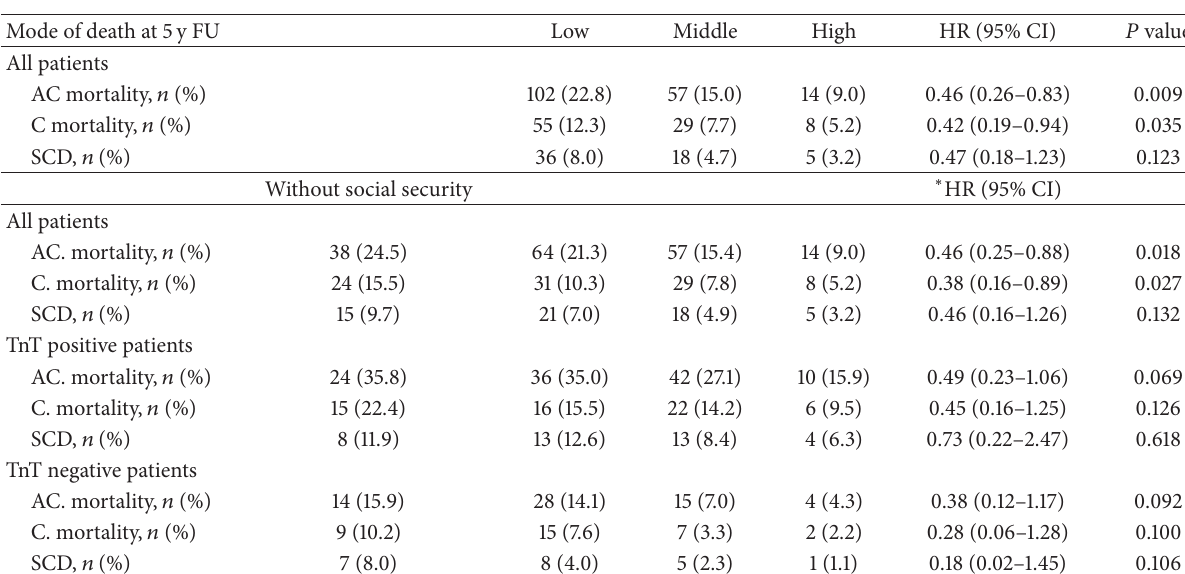
Table 4: (a) Mortality adjusted for gender and age at 5-year follow-up in four groups: low, middle, and high socioeconomic groups, respectively, and patients without social security. (b) Mortality adjusted for several variables at 5-year follow-up in four groups: low, middle and high socioeconomic groups, respectively, and patients without social security.